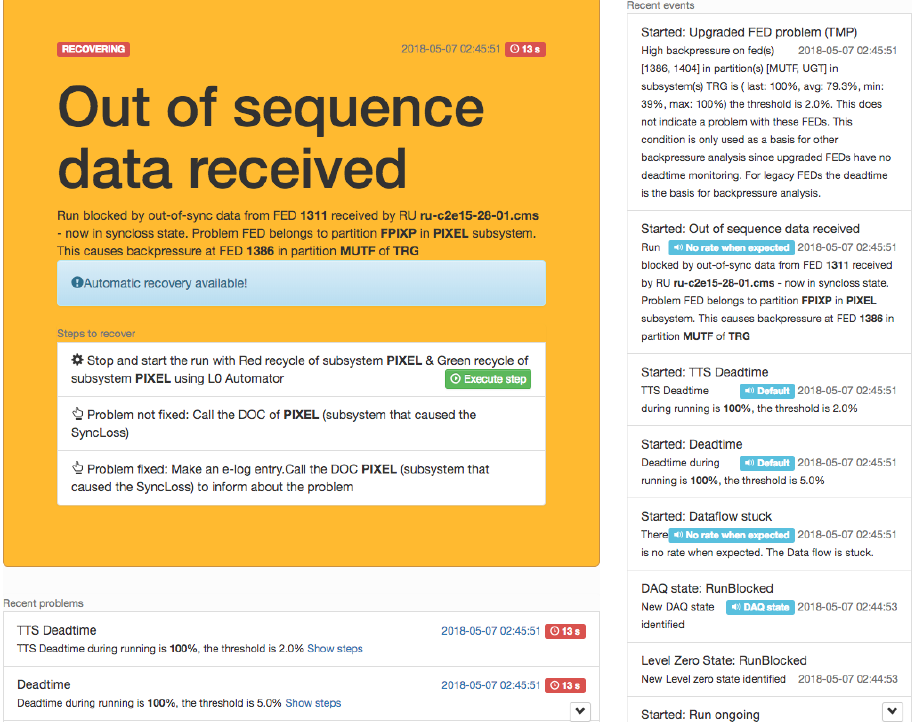
Fig. 4. The web-based Dashboard shows the current main problem with steps to follow for recovery, concurrent problems and the history of problems (left frame). It also shows the history of all notifications received and whether a sound alert was triggered (right